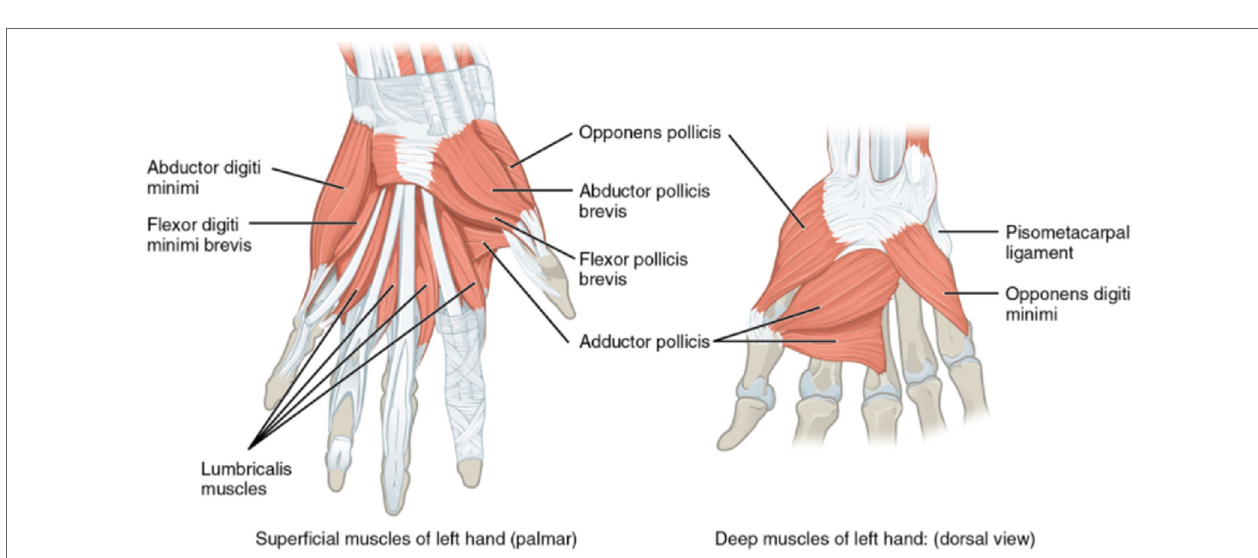
FiGURe 4 | Intrinsic muscles in the hand (http://philschatz.com/anatomy-book/resources/1121_Intrinsic_Muscles_of_the_Hand.jpg) (Last accessed: 23/06/2017). There are four dedicated intrinsic muscles to control the thumb. First interossei muscle which is attached to the adjacent sides of thumb and index finger metacarpal bones is not shown.